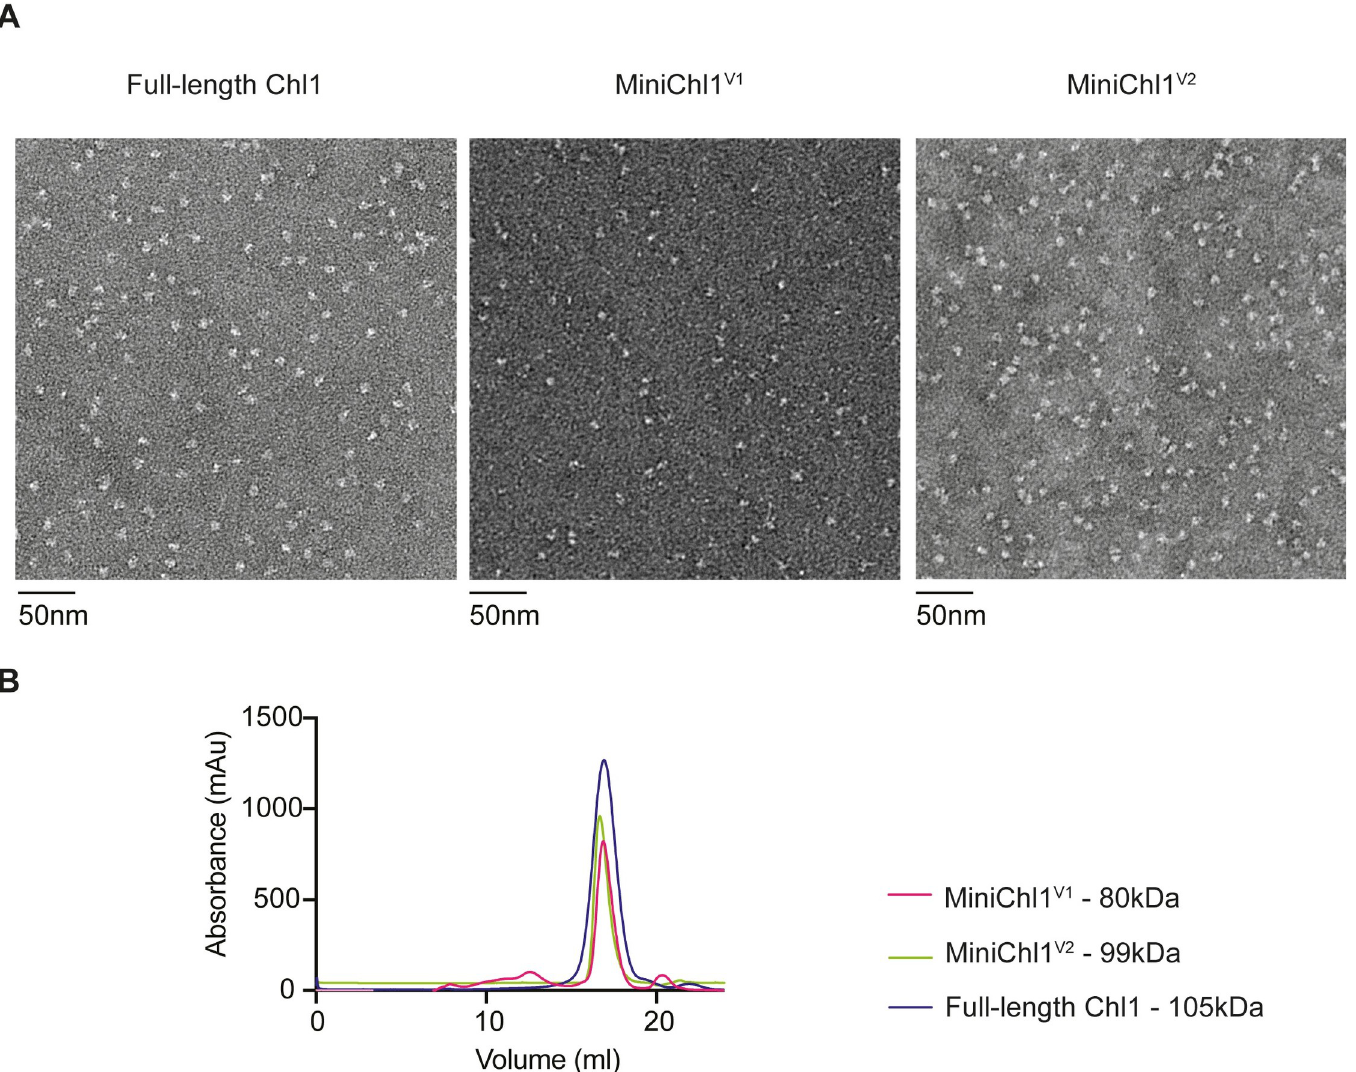
Fig 5. Deletion of the insert of Chl1. ( A) A comparison of the full-length Chl1 protein and two internal deletions of the insert to create MiniChl1 V1 and MiniChl1 V2 , respectively, using negative staining. Note poor particle quality in the MiniChl1 V1 construct. ( B) An overlay of the elution profiles of all three proteins, and their molecular weights.